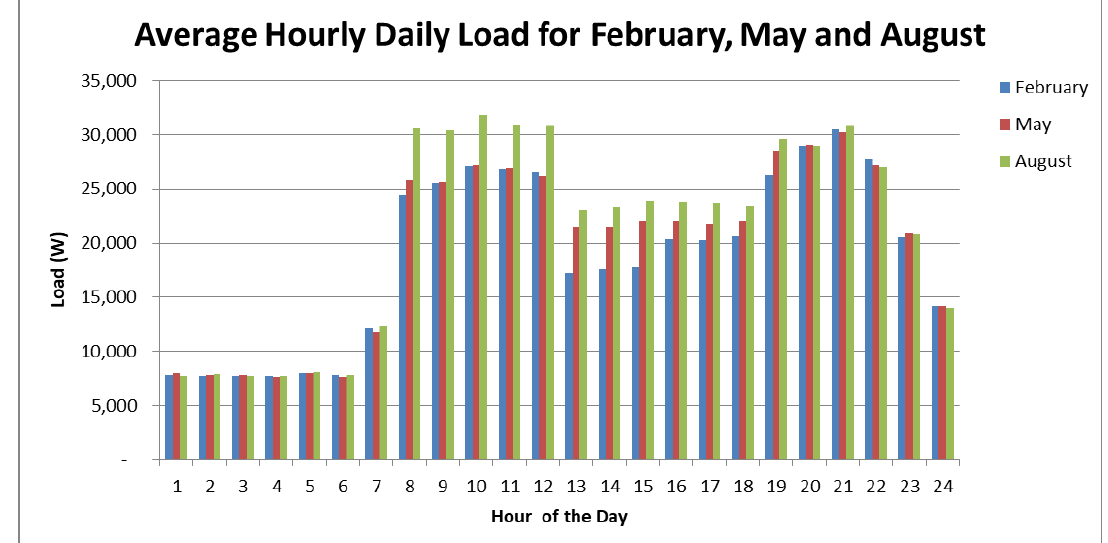
Figure 7. Average hourly daily load variation for February, May, and August.